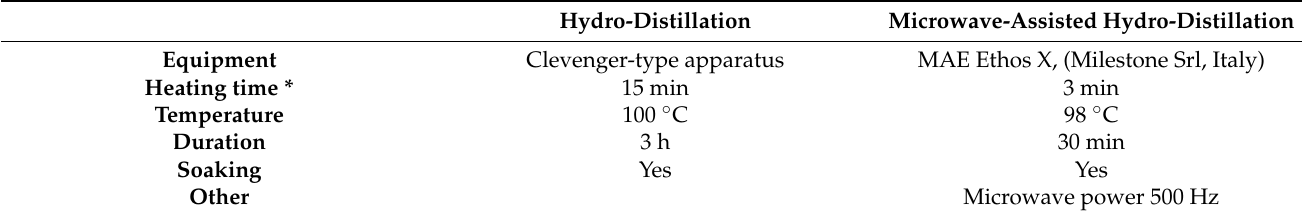
Table 4. Parameters of the used essential oil isolation